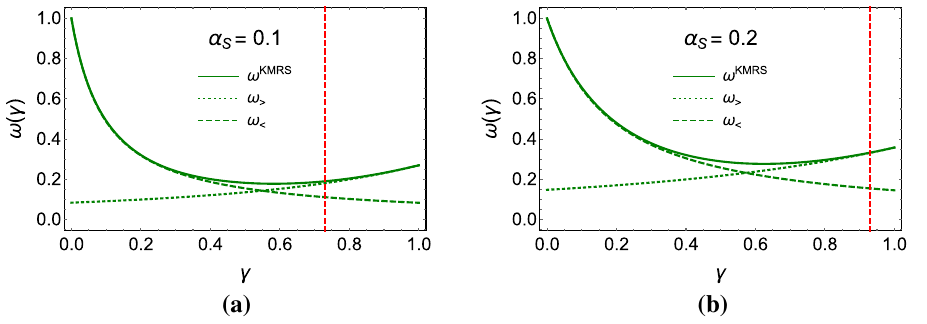
Fig. 1 The eigenvalues ω KMRS versus γ . The vertical dashed lines show the value of ¯ γ = 1 − γ cr , which is given by Eq. (21), for differ- ent values of ¯ α S . ω > is given by Eq. (19), while ω < is solution to the following equation: ω < = ¯ α S ( 1 − ω < )